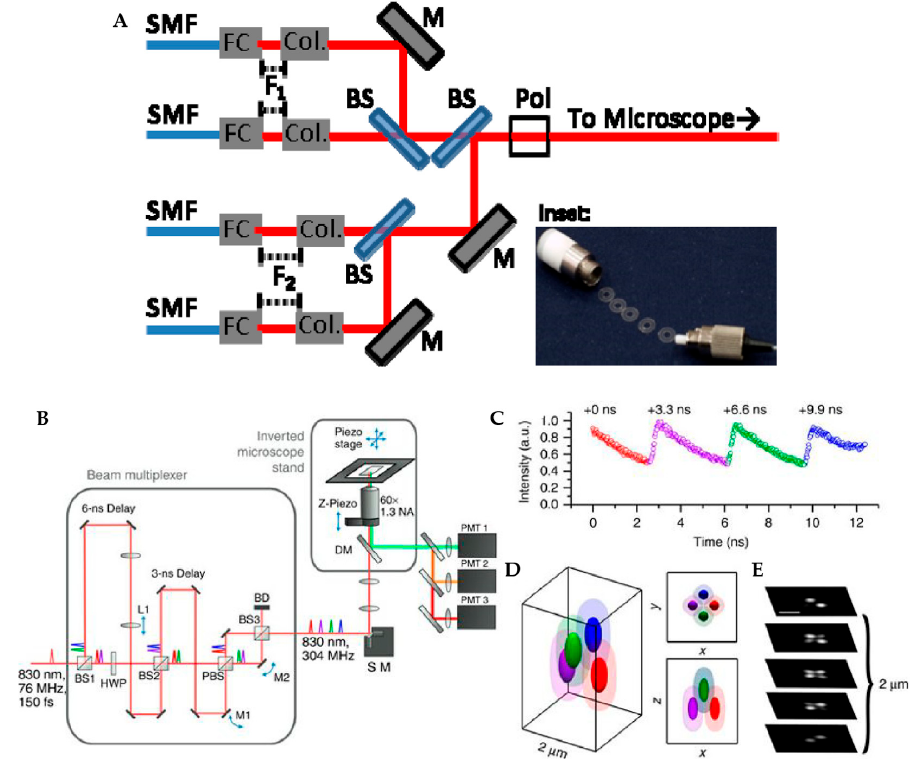
Figure 9. ( a ) Schematic of tetrahedral excitation tracking setup, where four laser diode beams